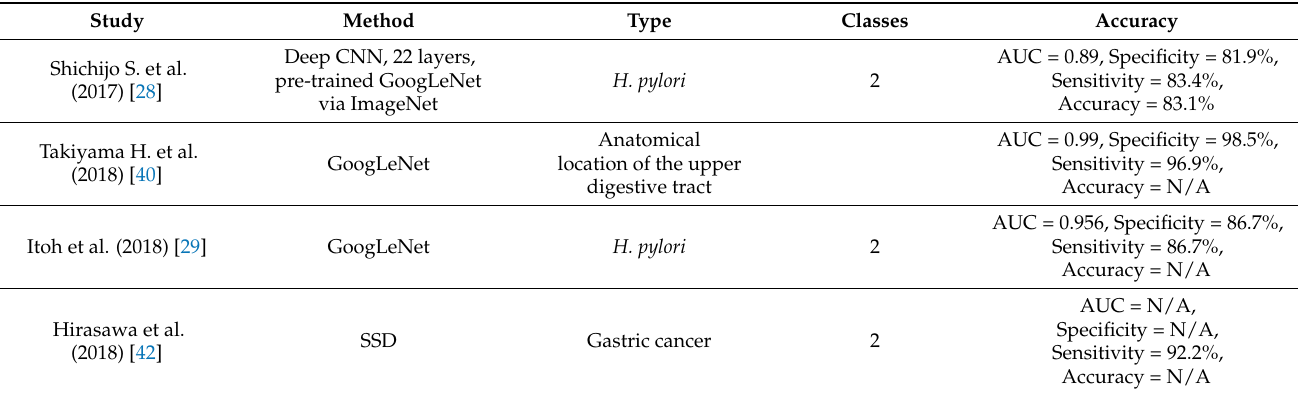
Table 5. Comparison of the proposed approach with literature on similar endogastric diagnosis classification